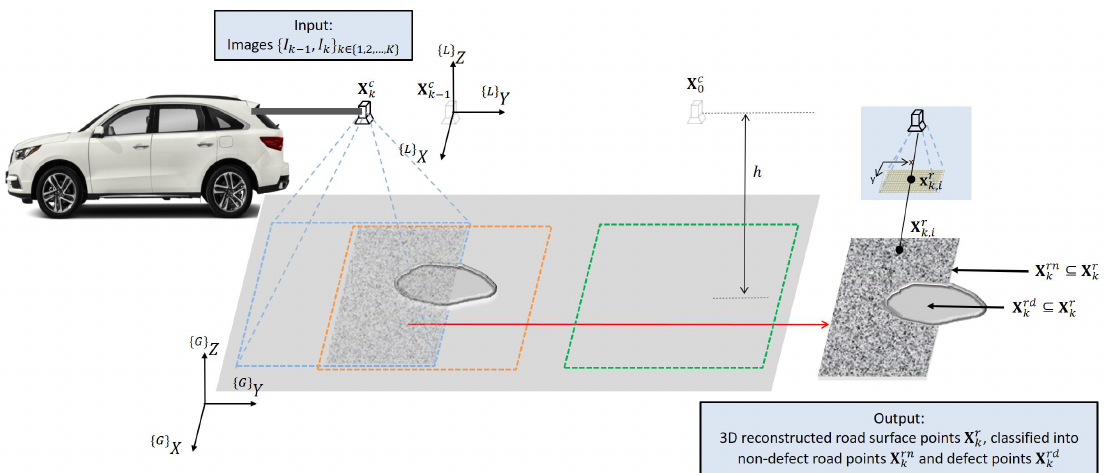
Figure 1. Road surface reconstruction settings for defects detection from one downward-facing camera. 3D point cloud are reconstructed from consecutive images to represent the road surface, followed by classifying the road into defective and non-defective